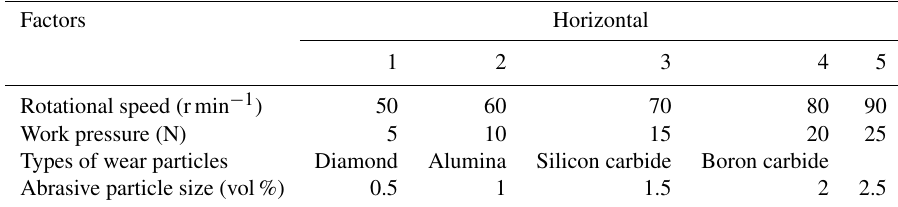
Table 1. Experimental factor parameter table.